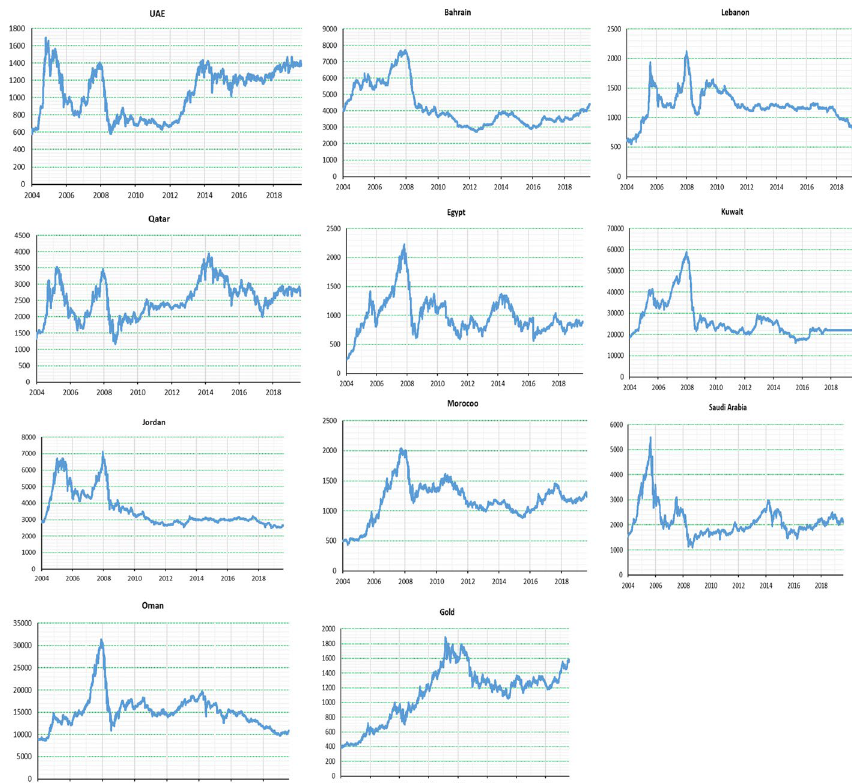
Fig. 2 Time evolution of MENA stock indices and gold prices ($/ounce). Notes The above figures show the dynamics of stock market indices of the MENA region and gold prices. The X-axis (Y-axis) indicates time and index or price level